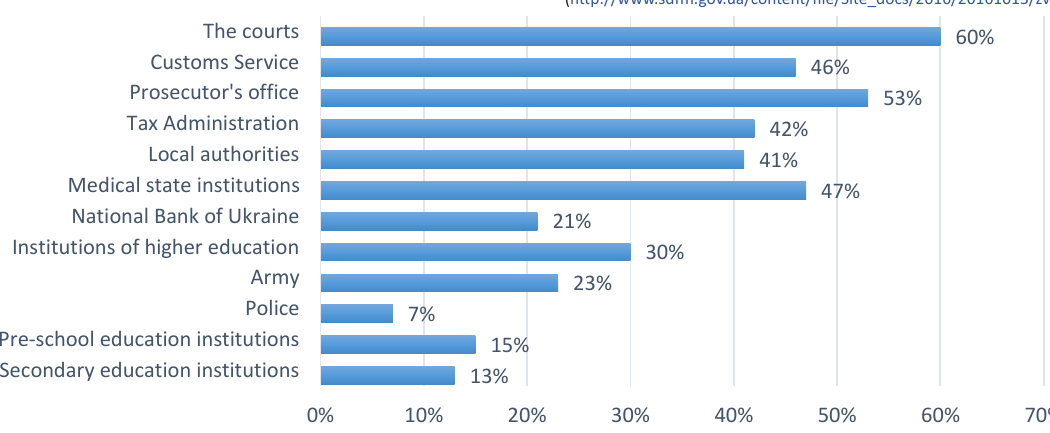
Figure 1. Corruption level in various spheres and institutions in Ukraine, 2016